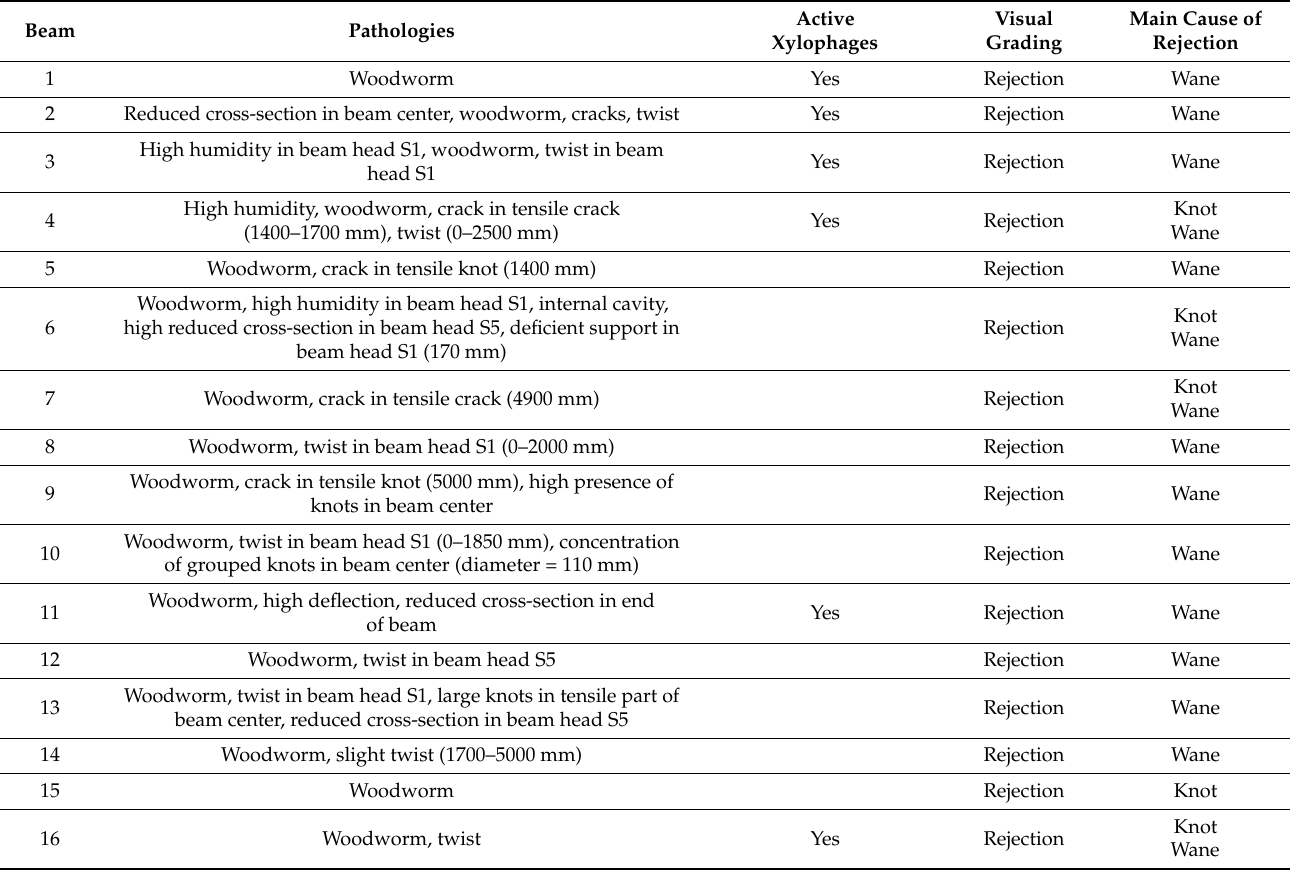
Figure 22. MoE st,c versus MoE dyn,c .